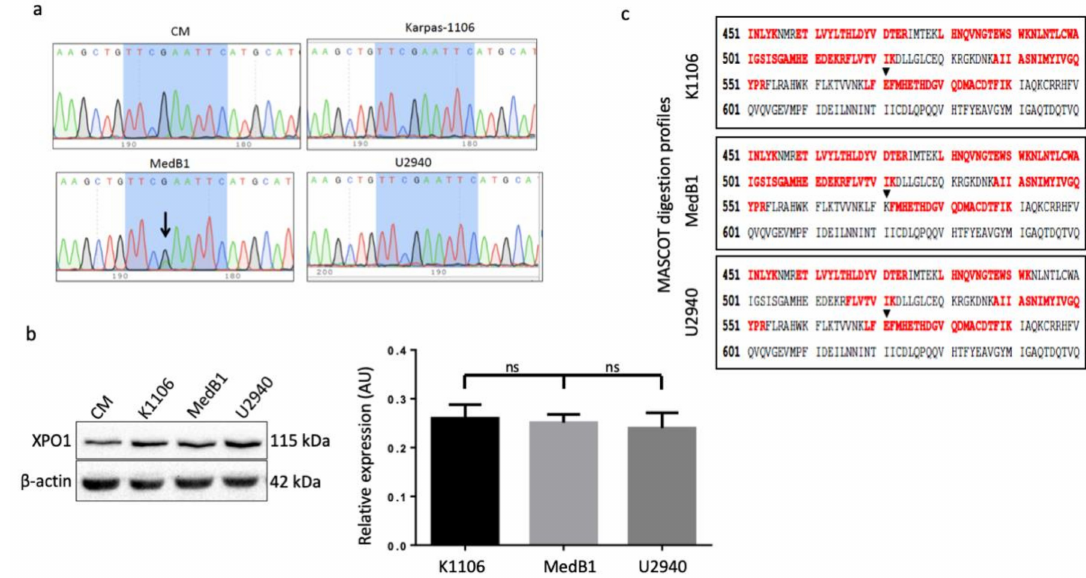
Figure 2. XPO1 E571K mutation is present in the mRNA and protein of MedB1 cells. ( a ) Total RNAs were purified from PMBL and CM cells. The relevant region of the XPO1 gene was amplified by RT-PCR with the primers presented in the Table S8. XPO1-PCR fragments were sequenced using the Sanger method. The resulting profiles are shown. The mutation present in MedB1 cells is arrowed. ( b ) Whole-cell proteins were purified from cultured cells, separated on SDS-PAGE, transferred onto nitrocellulose sheets. Blots were cut in strips and incubated with an anti-XPO1 Ab. An anti- β -actin Ab was used as a control of loading and transfer (Table S7). The experiment was done three times and the level of XPO1 protein expression was estimated by densitometry. ns, not significant with the t -test. ( c ) Whole-cell protein extracts were obtained from the three PMBL cell lines. XPO1 was immunoprecipitated with an anti-XPO1 Ab (70% of total proteins were immunoprecipitated using 0.15 µ g of Ab as evaluated in Figure S2b), processed and submitted to mass spectrometry (MS). MS-sequenced peptides from XPO1 found by Mascot database matches are shown in red over the theoretical sequence in black. Black triangles indicate position 571 of the three sequences from the three cell lines. The Mascot minimum scored over 25 when the minimum Mascot score was 16 for p < 0.05. Relevant mass spectra annotations are available in Figures